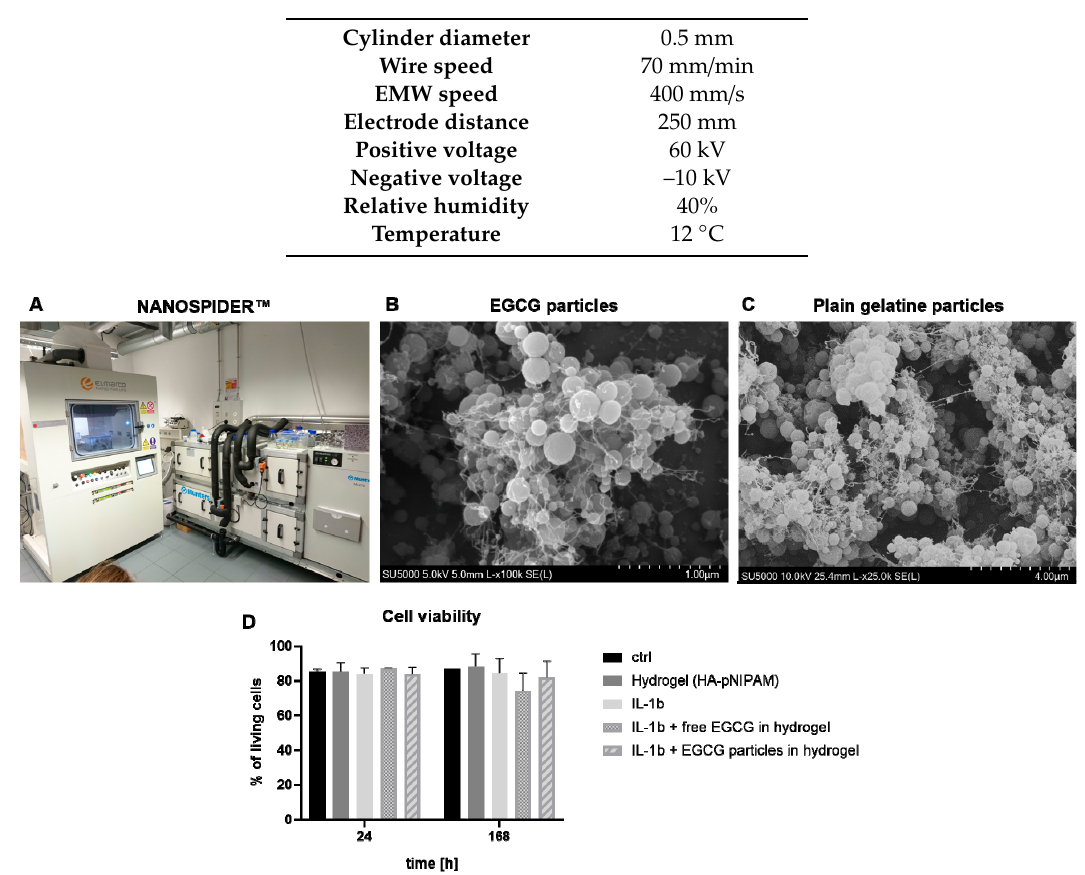
Figure 5. Industrial electrospraying of EGCG particles. ( A ) Electrospinning device NANOSPIDER ™ ; ( B ) representative SEM image of EGCG particles produced using NANOSPIDER ™ technology; ( C ) representative SEM image of plain gelatin particles produced by NANOSPIDER ™ technology; ( D ) cytocompatibility of the EGCG delivery system (= upscaled EGCG particles in the hydrogel) in 3D alginate beads treated with 5 ng/mL IL-1 β for 24 h or seven days ( n = 1 ‒ 5, Kruskal ‒ Wallis with Dunn’s